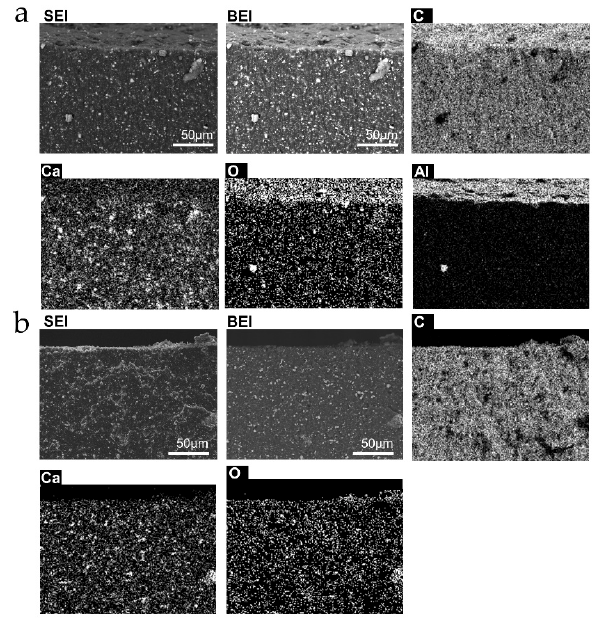
Figure 7. Micrographs and elemental distribution maps of cut surfaces normal to the tubing length. ( a ) outer surface; ( b ) inner surface from sample L. The scale bars in the SEI and BEI micrographs apply to the other images from the same area.